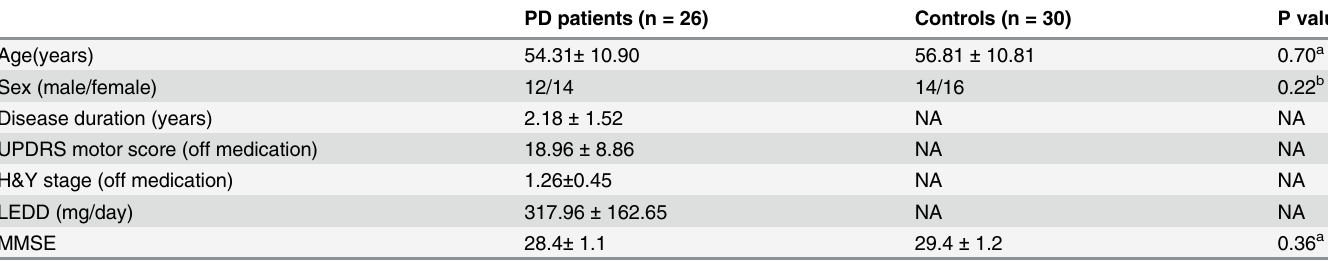
Table 1. Demographic characteristics and clinical status of each